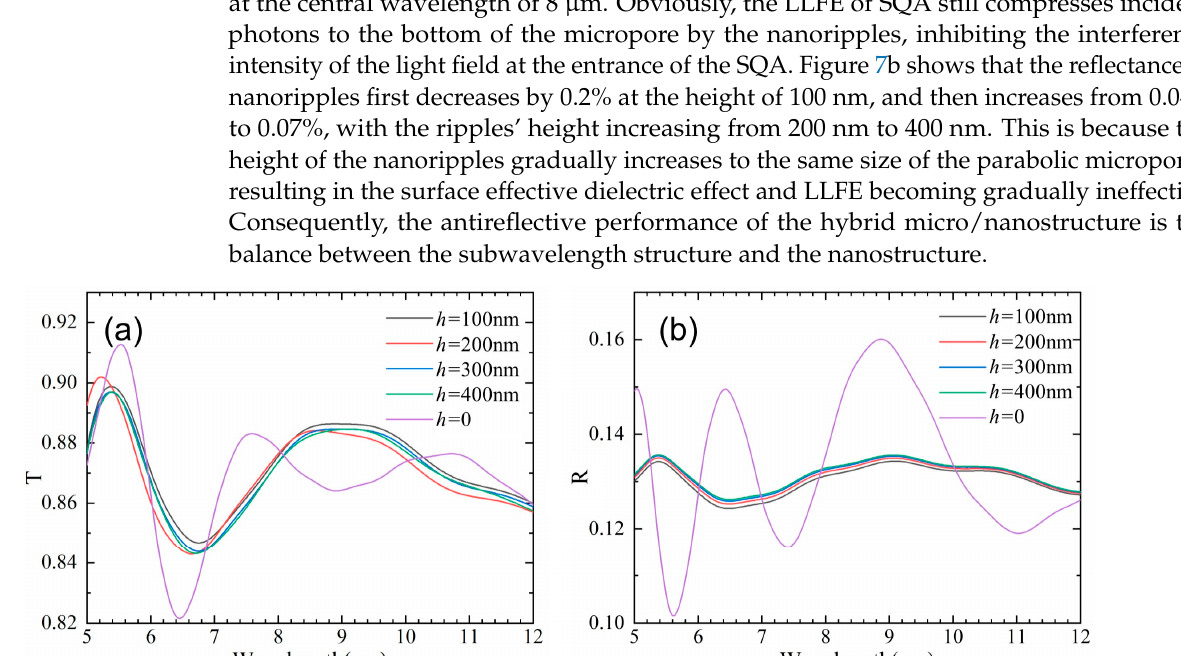
Figure 6. Optical field distribution of parabolic holes in the incident wavelength of 8 μ m ( a ) and 12 μ m ( b ), and nanoripple numbers of 2 ( c ), 3 ( d ), 4 ( e ), and 5 ( f ) in the incident wavelength of 8 μ m.